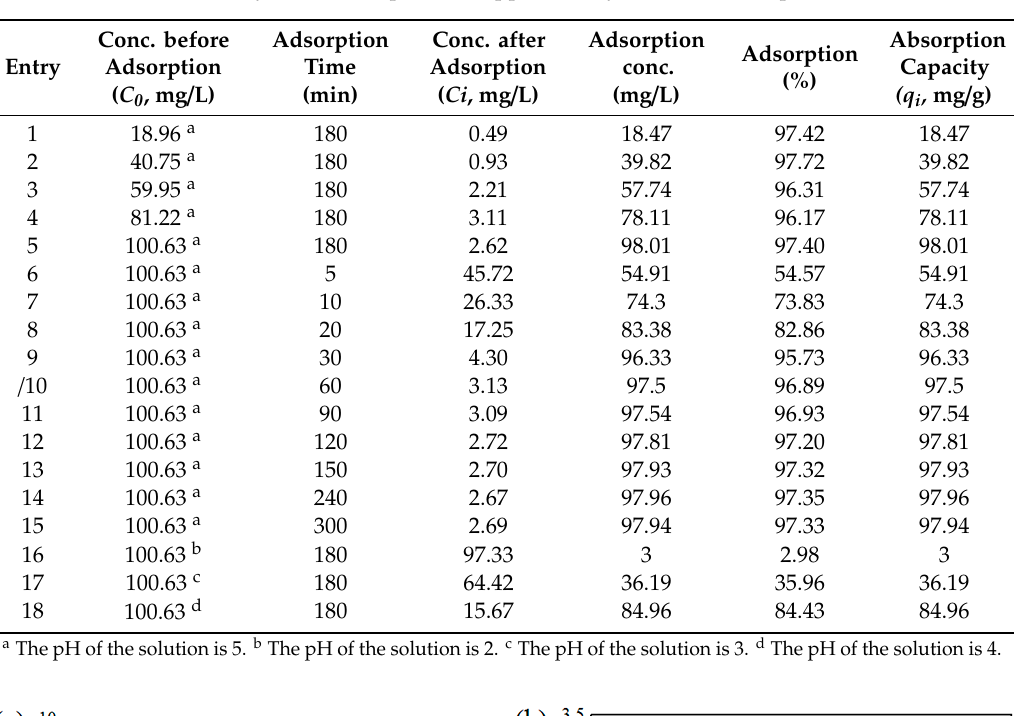
Table 1. Dynamic adsorption of copper ions by chitosan microspheres.